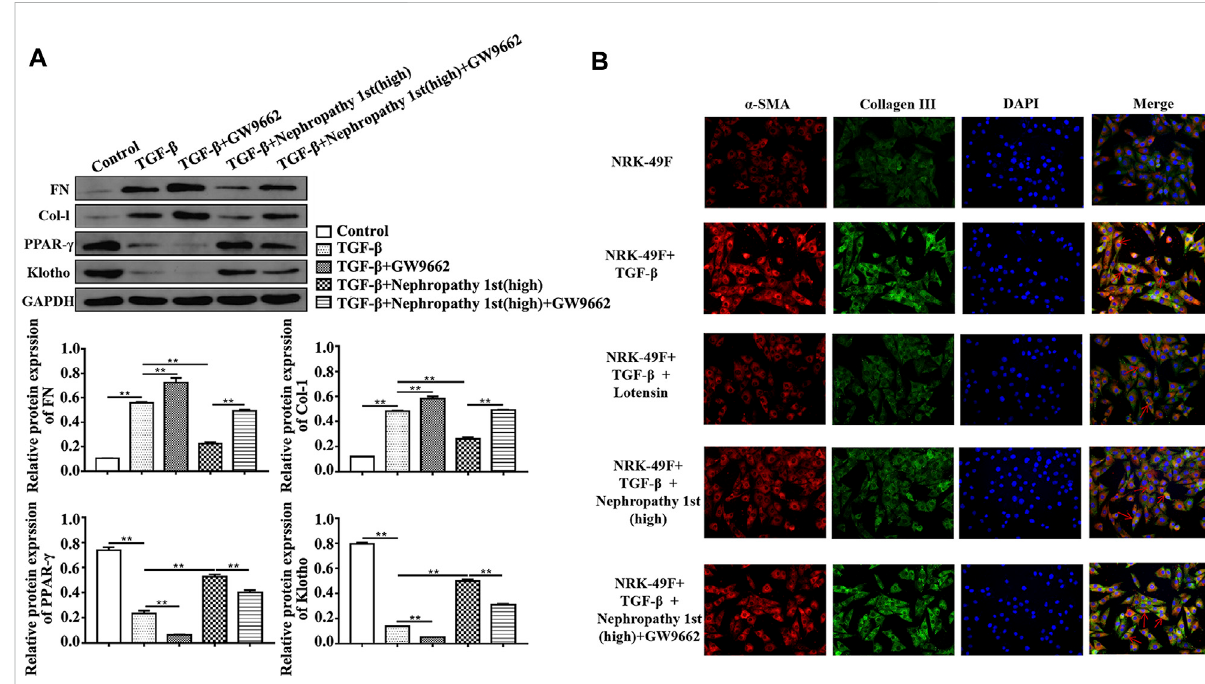
FIGURE 5 Inhibition of PPAR γ by GW9662 abrogated the anti- fi brotic role of Nephropathy 1st. (A) Western blot showed the electrophoretic band of FN, Col-I,PPAR γ ,andKlotho;andtherelativeproteinexpressionofFN,Col-I,PPAR γ ,andKlothobasedonthegrayvalueofWB. (B) Immuno fl uorescence (IF) technology showed the expression of α -SMA and collagen III protein level and theposition in NRK-49F cells treated with TGF- β 1 and GW9662 in the presence of lotensin or Nephropathy 1st. Data were representative of three independent experiments. *p < 0.05 and **p <